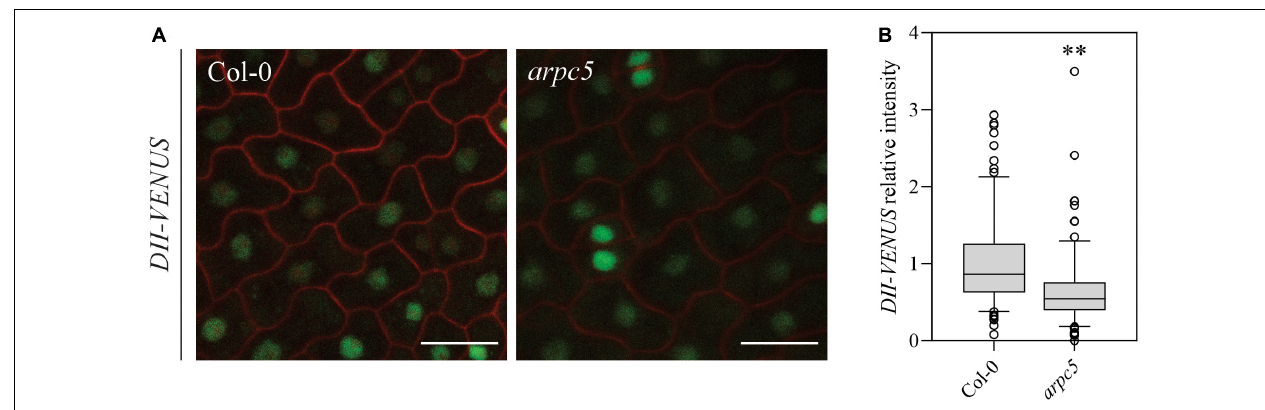
FIGURE 4 | Plants lacking functional ARP2/3 complex show increased active auxin-driven proteasomal degradation of the auxin input sensor DII-VENUS. (A) In vivo observation of DII-VENUS (green) in one-day-old wild-type and arpc5 seedlings (scale bar = 20 µ m) co-stained with PI (red). (B) Normalized DII-VENUS relative intensity ( n = 167 cells; three biological replicates; Student’s t -test, p < 0.0001).